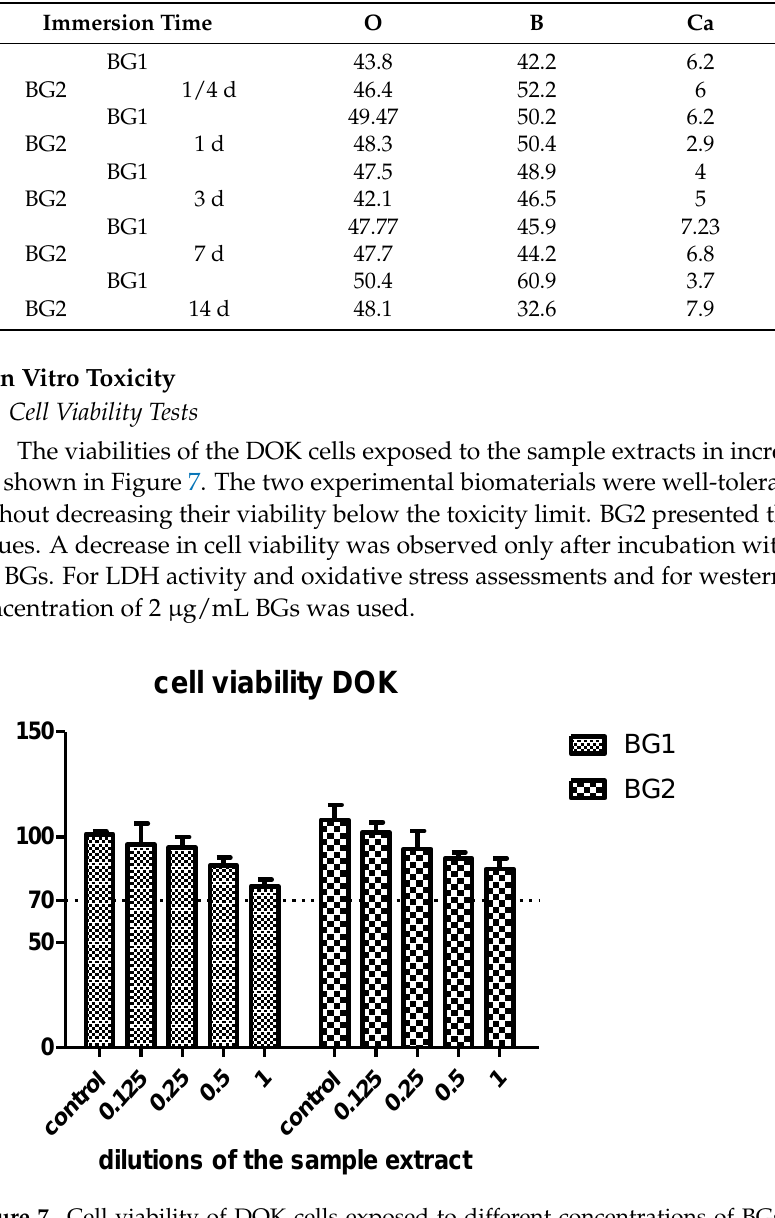
Figure 7. Cell viability of DOK cells exposed to different concentrations of BGs compared with control untreated cells. DOK cells were exposed to dilutions of the sample extract ranging between 0.125–1 and compared with control untreated cells. Data are presented as a mean of OD540 ± SD, n = 3 for each sample.